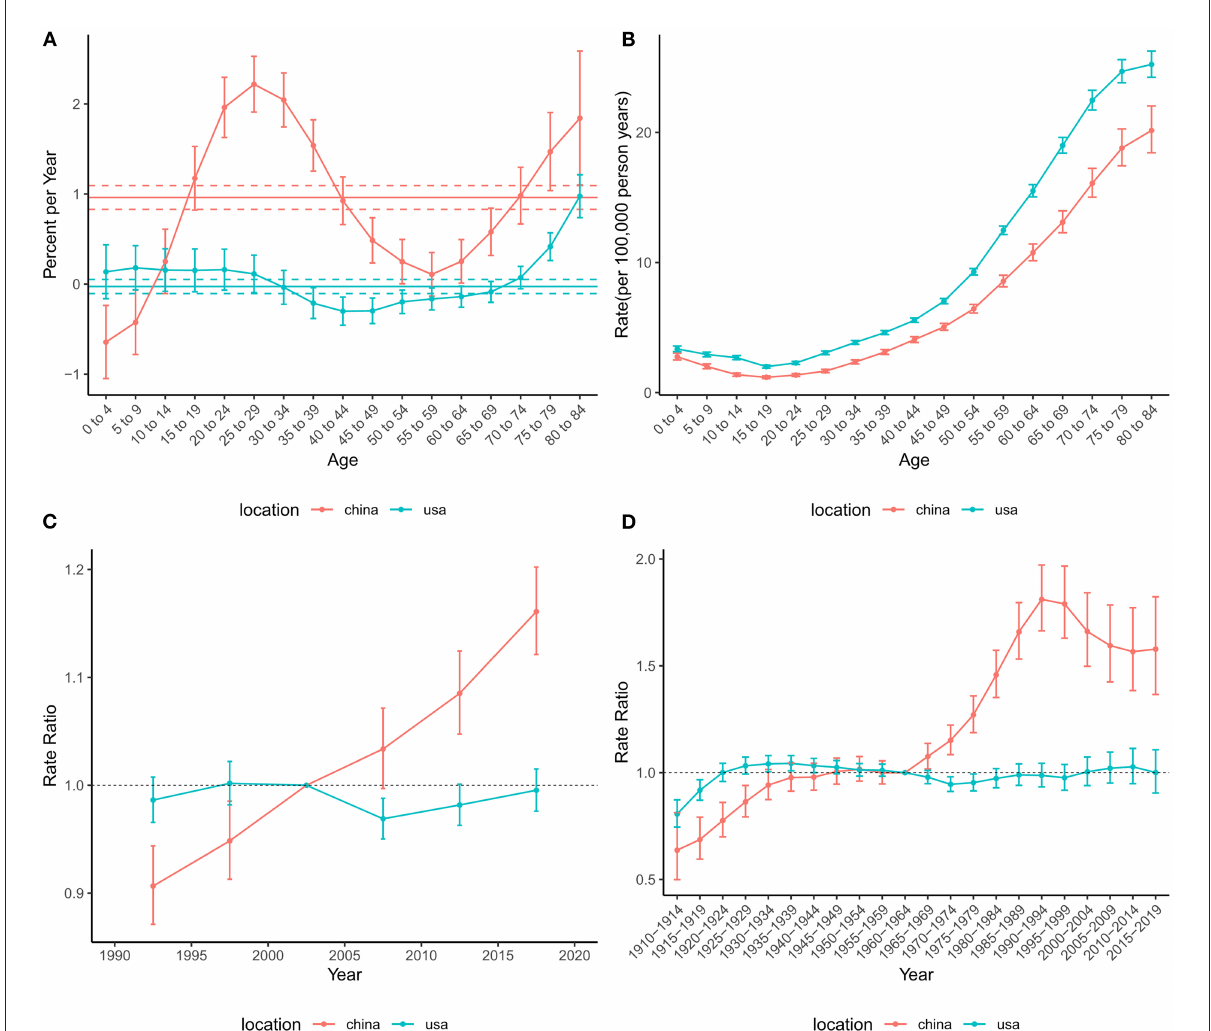
FIGURE3 Age-period-cohort effects on the incidence rate of brain and CNS cancers in China and the US. (A) Net drift and local drift values for brain and CNS cancers incidence rate in China and the US. (B) Longitudinal age curves for brain and CNS cancers incidence in China and the US. (C) Period effects on the brain and CNS cancers incidence rate in China and the US relative to the reference period (2000–2004). (D) Cohort effects on the brain and CNS cancers incidence rate in China and the US relative to the reference cohort (1960–1964). Vertical solid bars represent the 95% confidence intervals. CNS, central nervous